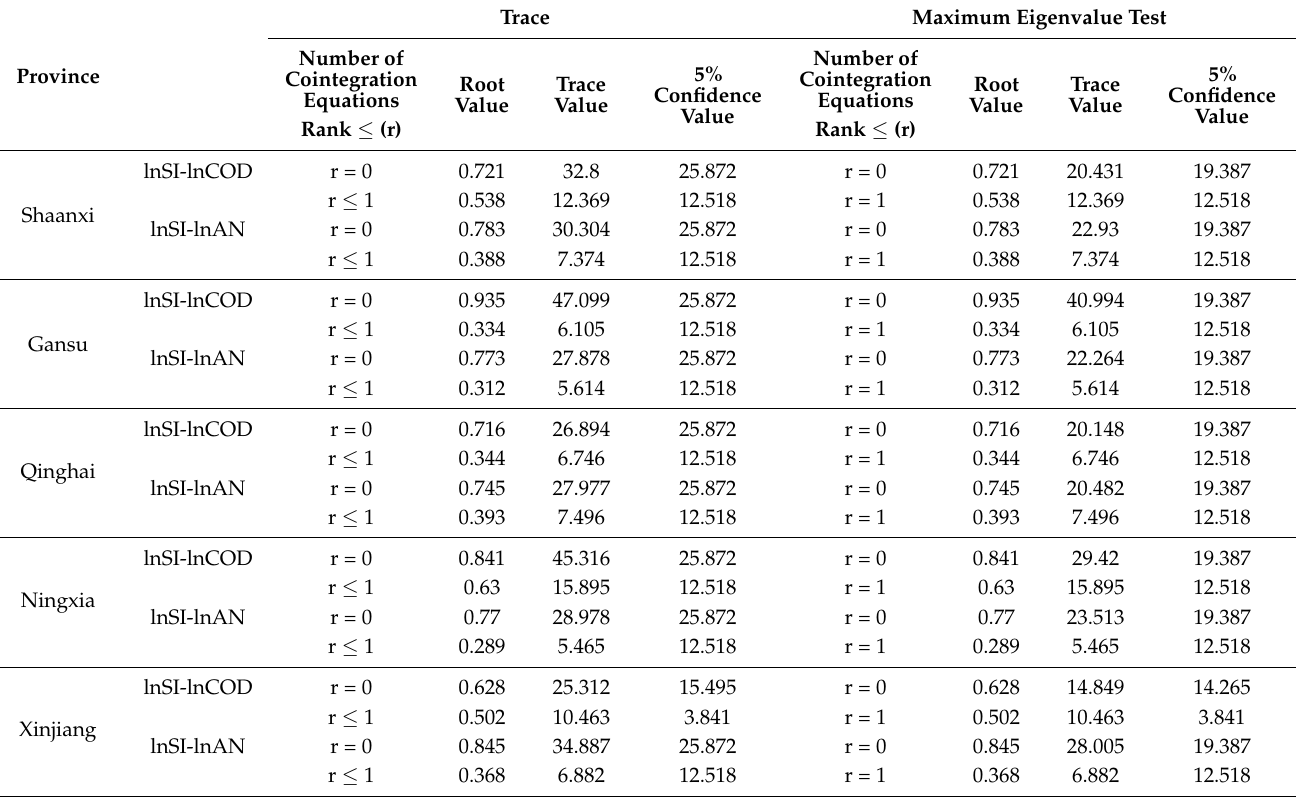
Table 2. Test results of the Johansen cointegration